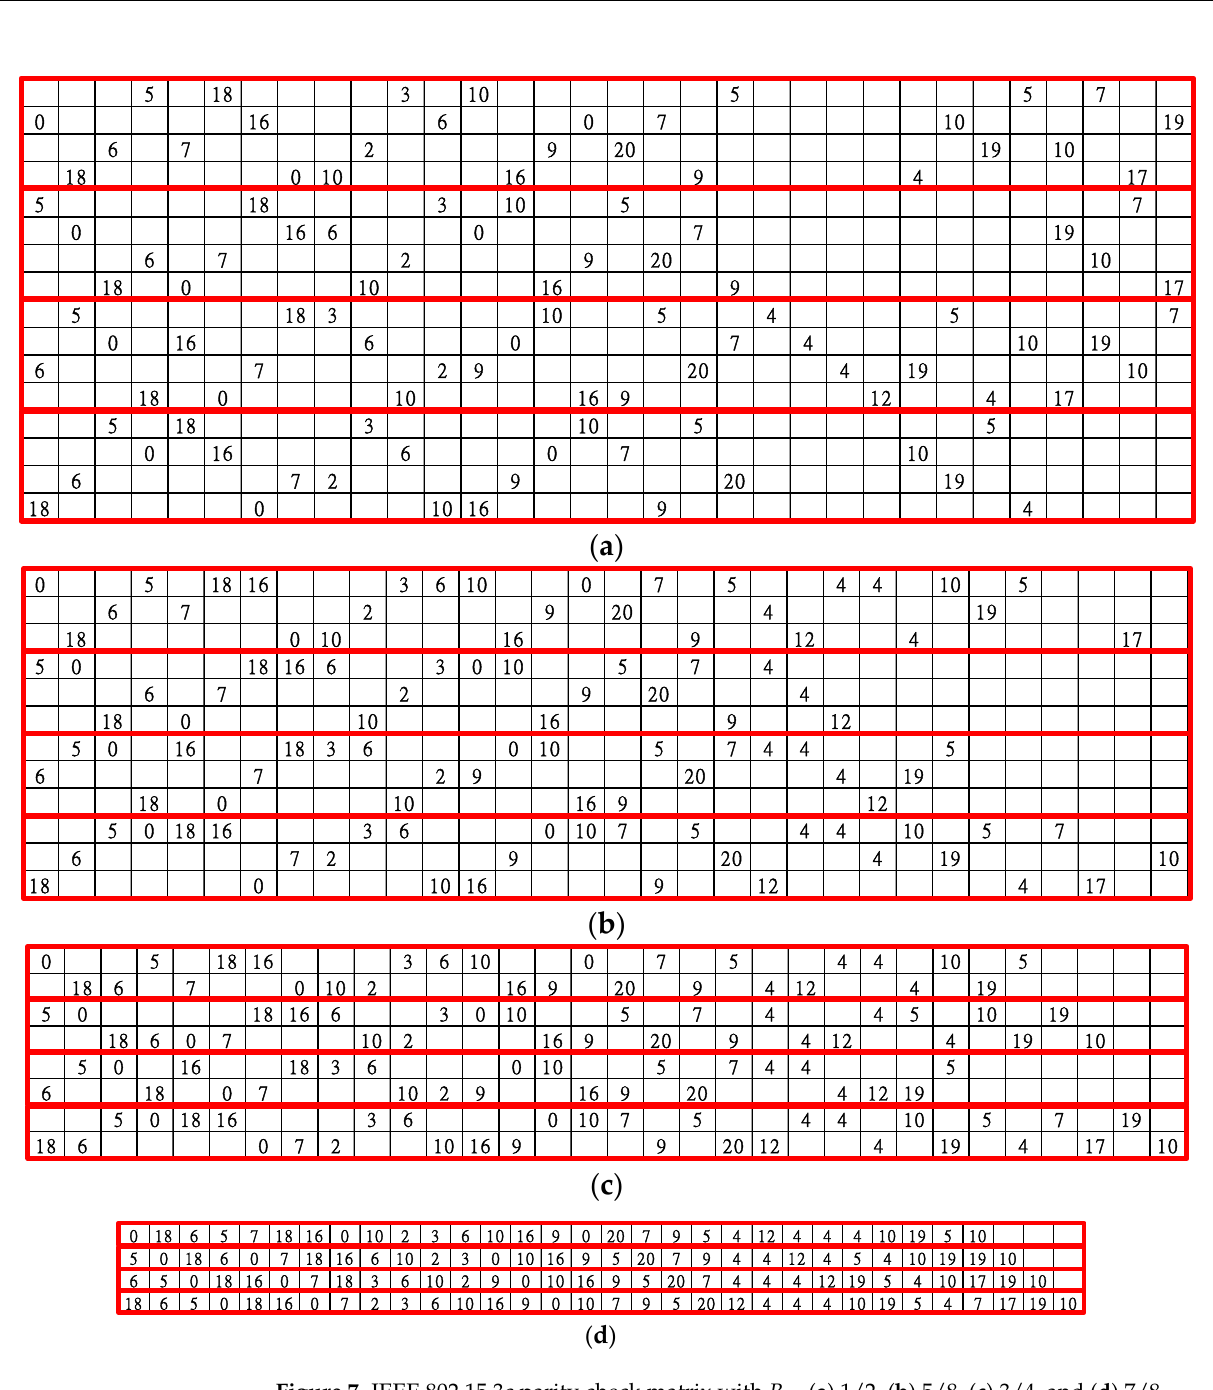
Figure 7. IEEE 802.15.3c parity check matrix with R = ( a ) 1/2, ( b ) 5/8, ( c ) 3/4, and ( d ) 7/8. IEEE 802.11ay is the upgraded standard of IEEE 802.11ad, and its QC-LDPC matrix is made up of the IEEE 802.11ad matrix in-place 2nd lifting, as shown in Figure 8. Taking R = 13/16 as an example, the first submatrix with a value of 29 is expanded into four submatrices after the 2nd lifting operation. The 2nd lifting matrix only has two values: 0 and 1. Zero indicates that the value of the original matrix is expanded in the format of the identity matrix, and 1 indicates that the value of the original matrix is expanded in the format of the identity matrix and shifted by one unit to the right. The IEEE 802.11ay matrix and the 2nd lifting matrix are shown in Figures 9 and 10. Finally, we unified the three standard parameters in Table 2. Table 2. Parameters of three standards for 60 GHz wireless local area networks.